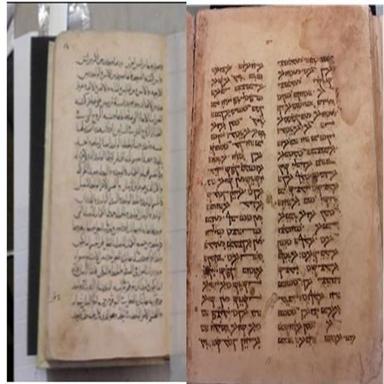
Comparison of the color between a pag. 50 (left) and pag. 104 of volume 410 (Vat.ar.410 ff. 50r and 104r).